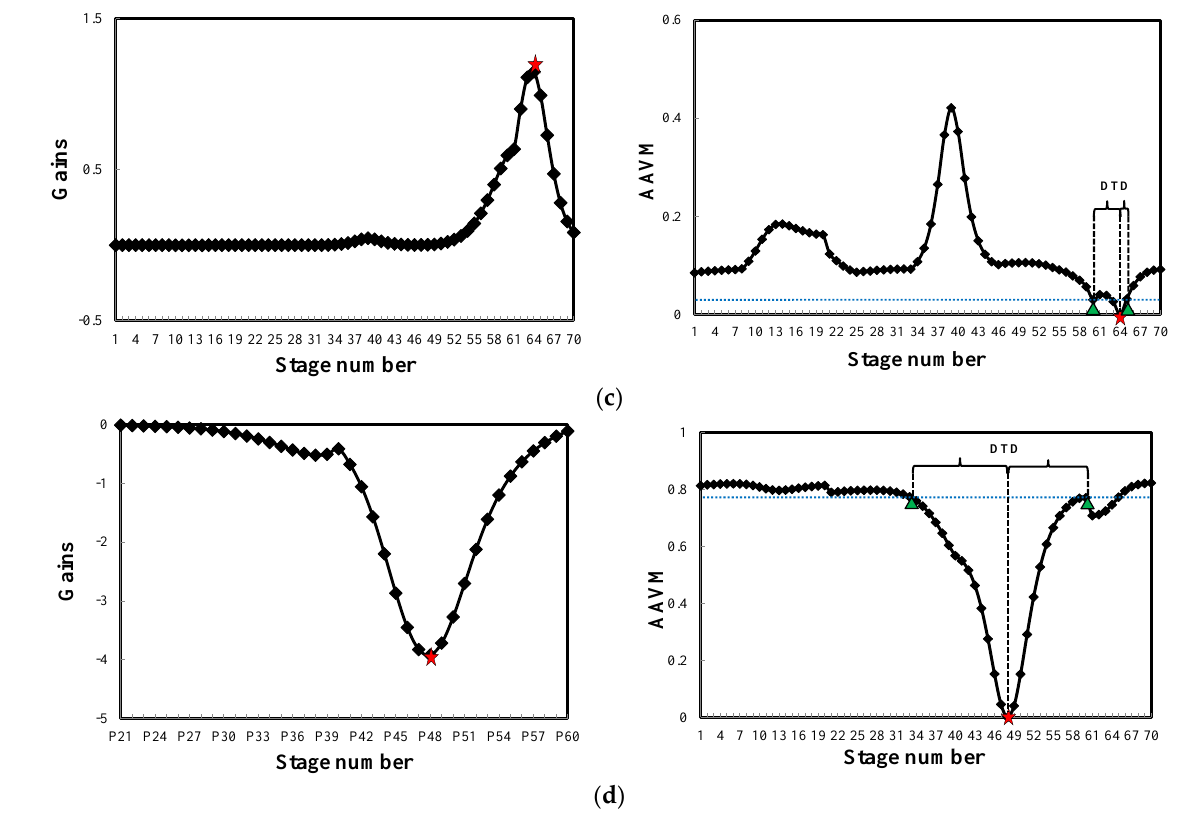
Figure 9. Results of the sensitivity analysis and AAVM analysis (Example II): ( a ) top control loop; ( b ) sidestream control loop; ( c ) bottom control loop; ( d ) prefractionator control loop. (Red pentagram: sensitive stage; green triangle: reference stage).